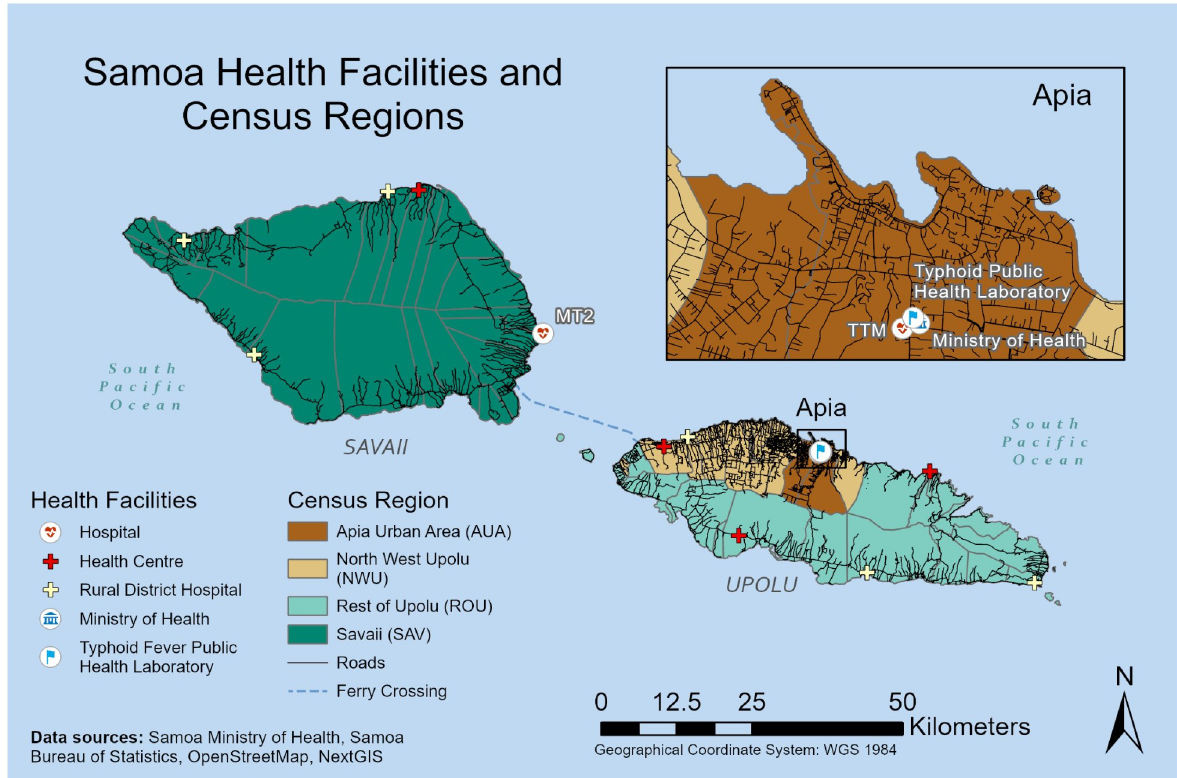
Fig 1. Map of Samoa with census regions, roads, and health facilities. Samoa is comprised of two primary islands, Upolu to the east and Savaii to the west. About three quarters of the population and the capital town of Apia are located on Upolu. The black lines indicate roads associated with populated areas, which are predominantly located around the periphery of the islands except for the urban areas where inland settlements are increasing. The islands are subdivided into four statistical census regions, 43 political districts (outlined in light grey), and > 300 villages (not depicted). The four colored geographic areas differentiate the four census regions: Apia Urban Area (AUA), North West Upolu (NWU), Rest of Upolu (ROU), and Savaii (SAV). AUA is most dense with ~25% of the total population. Apia is the capital seat of government and includes the Ministry of Health headquarters, Samoa Typhoid Fever Public Health Laboratory, and Tupua Tamasese Meaole (TTM) national hospital, which processes the blood cultures for Upolu (insert). NWU is mixed peri-urban and rural in population density and separates Apia from the inter-island ferry (navy dashed line) and adjacent international airport (not shown). The Malietoa Tanumafili II (MT2) hospital processes blood cultures for Savaii. The health facility icons indicate the two central hospitals with clinical microbiology laboratories, TTM and MT2, and the 6 district hospitals and 4 peripheral health centers. Base layer map available from